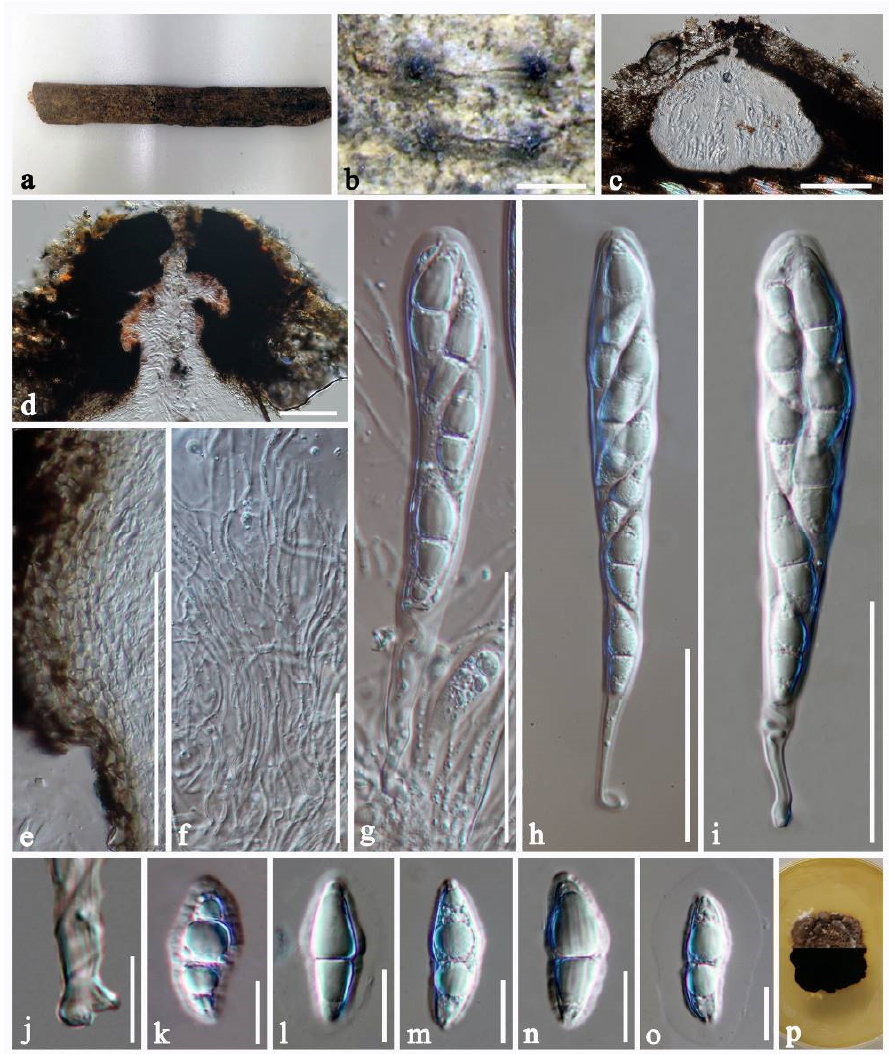
Figure 3. Anastomitrabeculia didymospora (MFLU 20-0694, holotype ). ( a ) Ascomata on bamboo. ( b ) Close-up of ascomata. ( c ) Vertical section of ascoma. ( d ) Ostiolar canal. ( e ) Peridium layer. ( f ) Trabeculate pseudoparaphyses. ( g – i ) Asci. ( j ) Pedicel. ( k – o ) Ascospores showing mucilaginous sheath. ( p ) Culture characteristics on PDA from above and below (9 cm diameter petri dish). Scale bar: ( b ) = 500 µ m, ( c ) = 200 µ m, ( d – i ) = 50 µ m, ( j – o ) = 10 µ m.